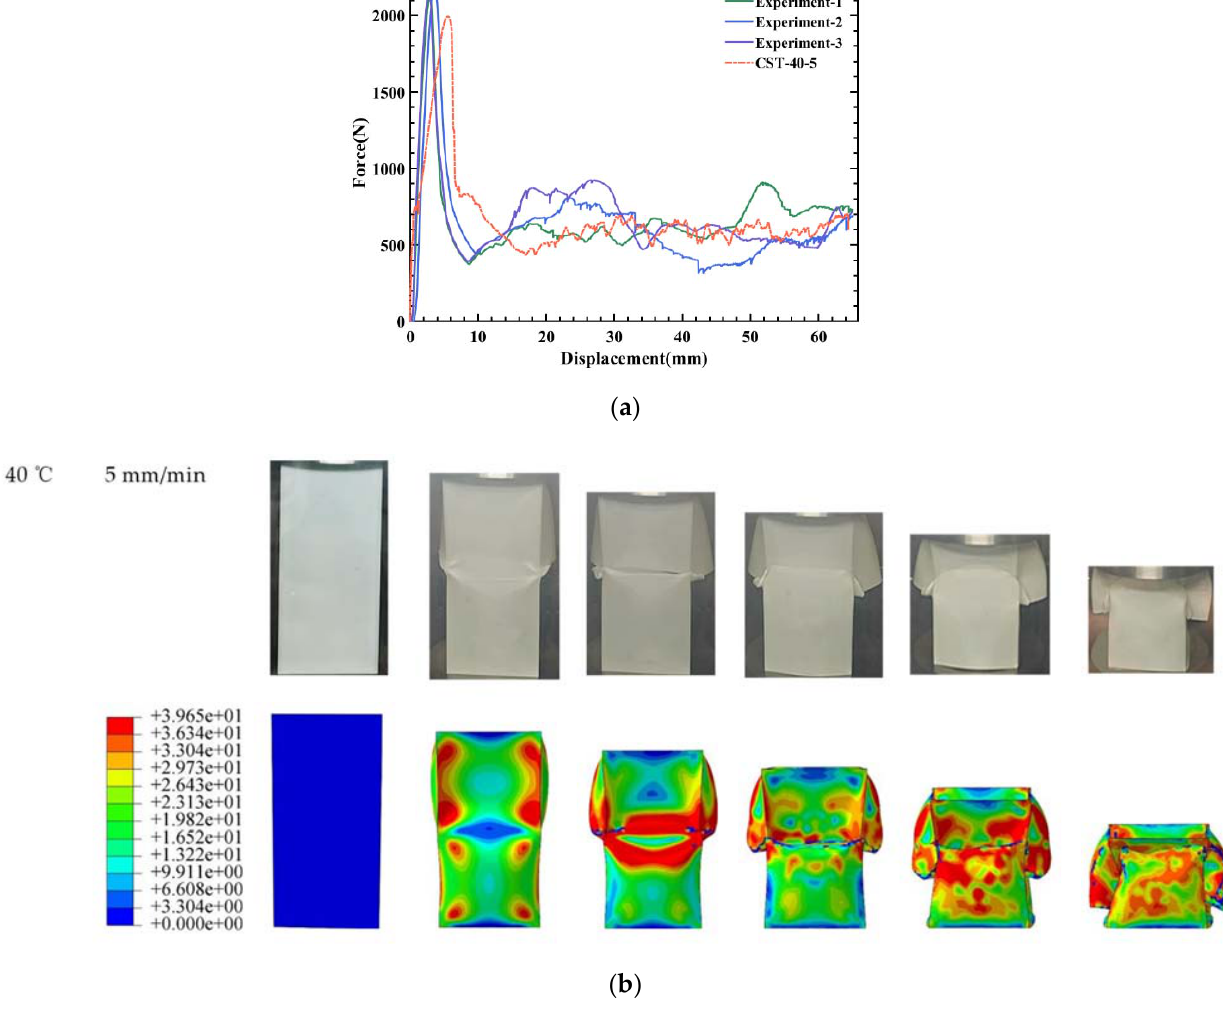
Figure 4. Validation of the finite element model: ( a ) force–displacement curves of experimental and finite element results; ( b ) comparison of deformation modes in the experiment and simulation.